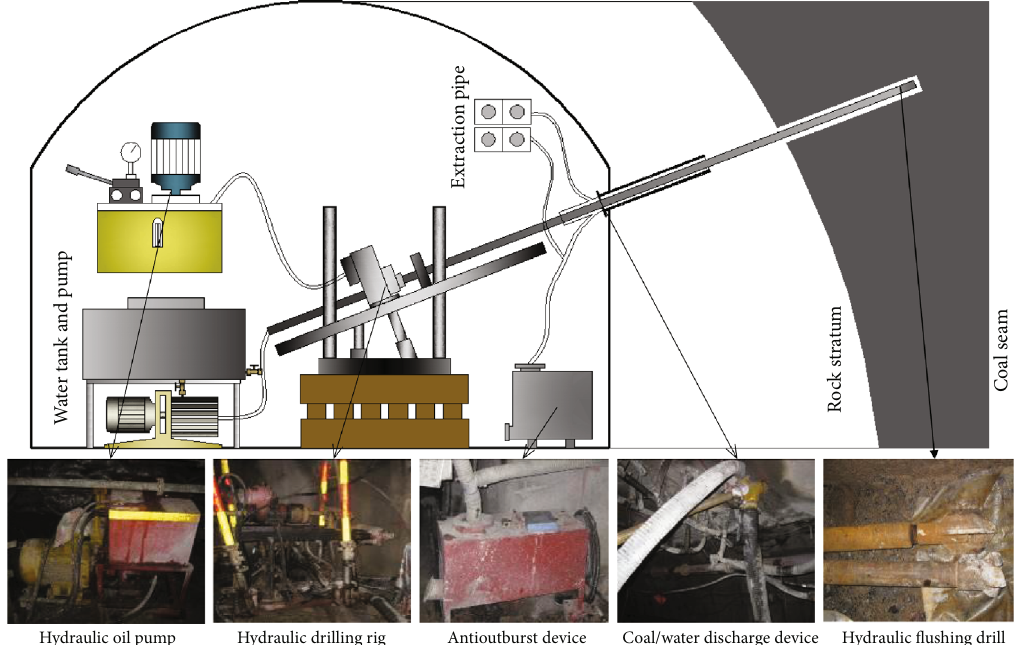
Figure 8: The system for the construction of the crossing borehole adopting hydraulic fl